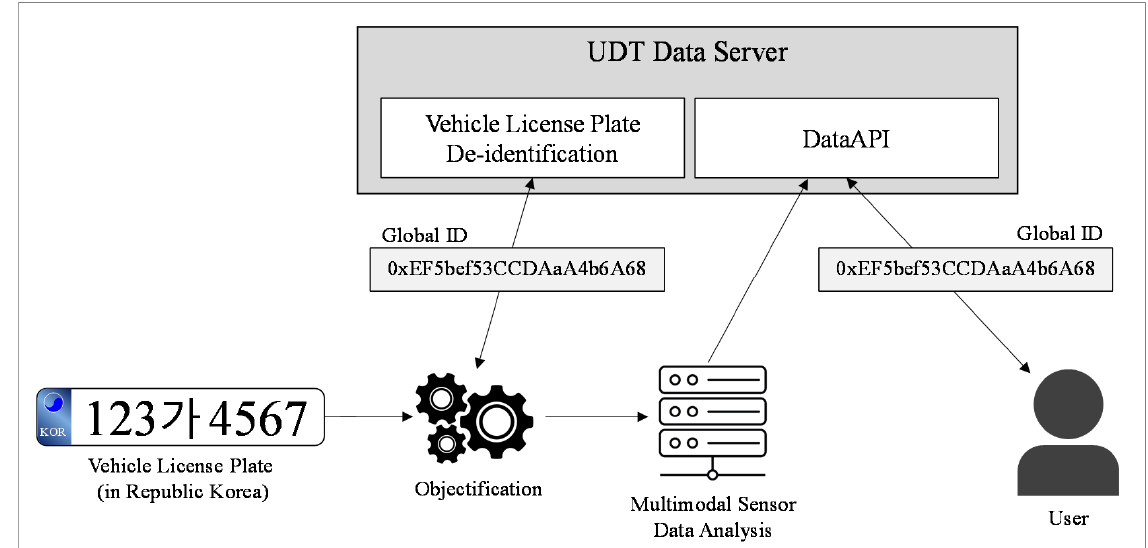
Figure 11. Data flow for the vehicle license plate de-identification and global ID generation method.